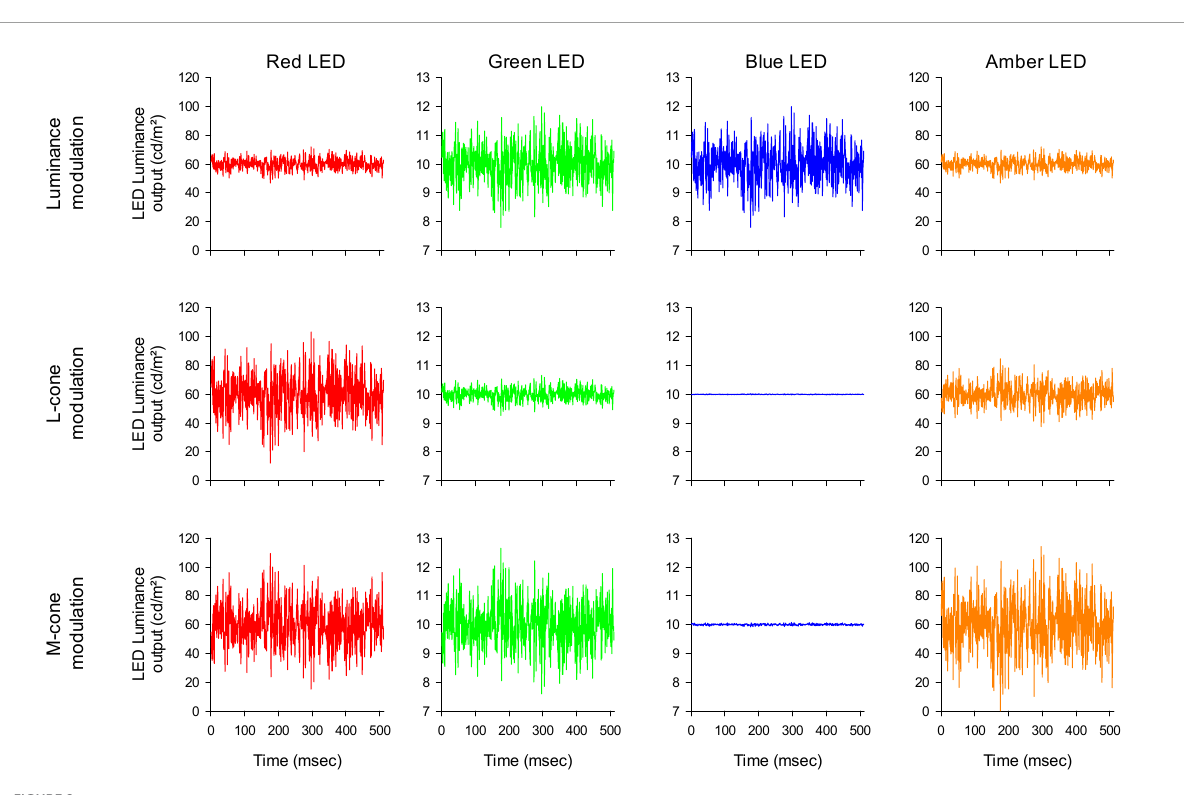
FIGURE2 Luminance output of the four different LEDs as a function of time, to obtain luminance (upper row) , L-cone isolating (middle row) and M-cone isolating (lower row) TWN stimuli.